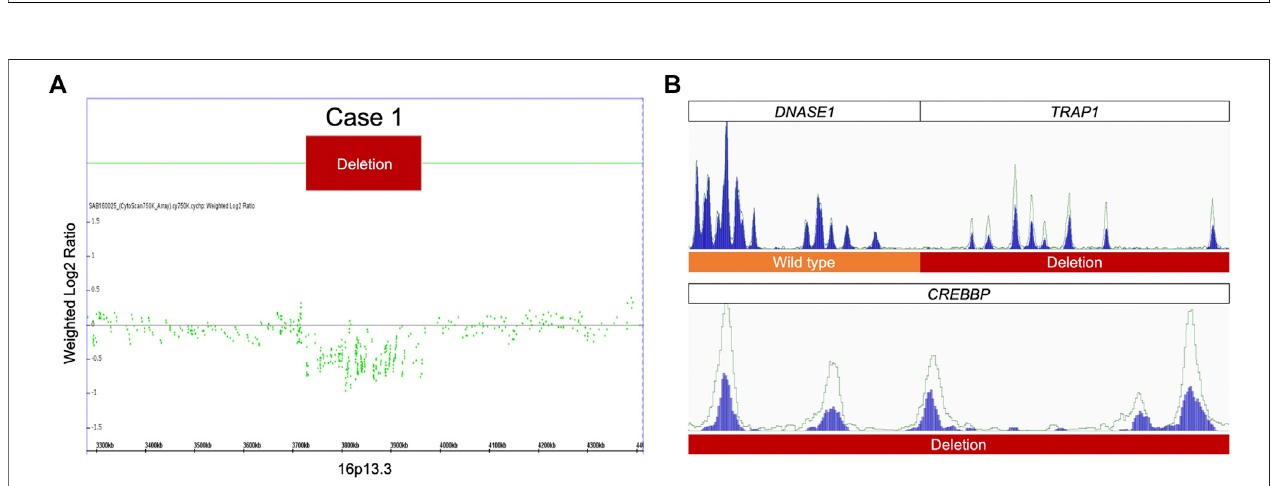
FIGURE4| MLPAandWESresults forcase1. (A) MLPAoftheproband showingheterozygousdeletionat 16p13.3. (B) AvisualizationoftheWESresults forcase 1 show fewer reads in the proband than in the healthy control, con fi rming the heterozygous deletion detected by MLPA.